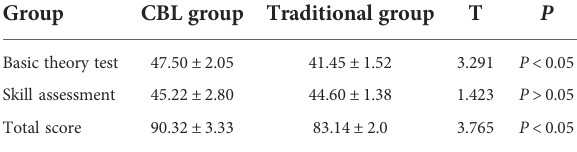
TABLE 2 Graduation examination results.